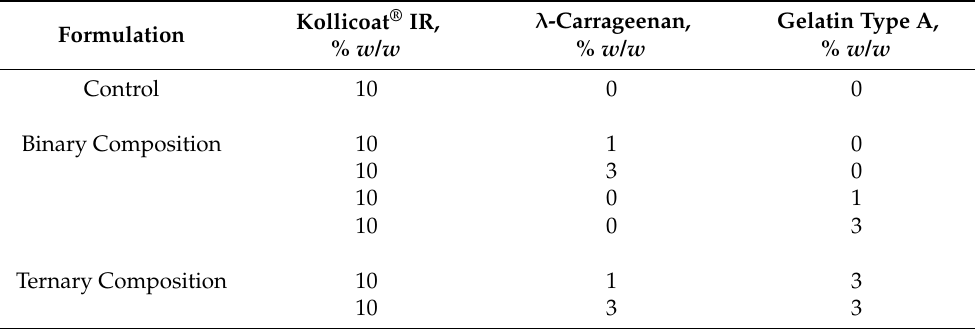
Table 1. Composition of control, binary and ternary coating solutions consisting main film forming polymer Kollicoat IR prepared as a 10% w/w -based solution with secondary component gelatin type A or λ -carrageenan at either 1 or 3% w/w